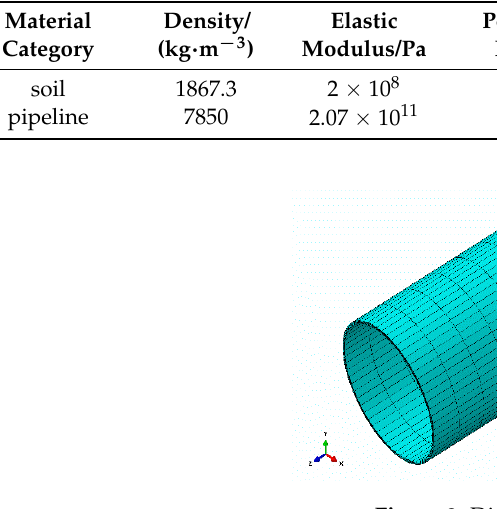
Figure 3. Division of the grid.